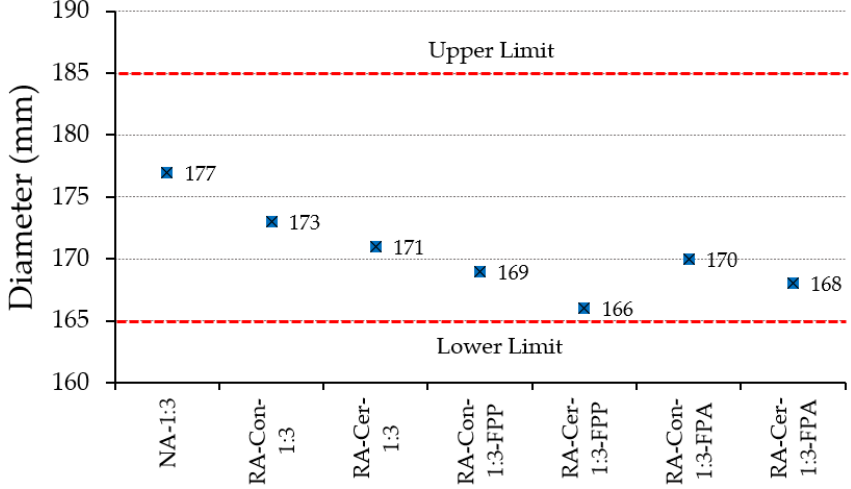
Figure 2. Consistency test results according to standard UNE-EN 1015-2: 2007 [54].